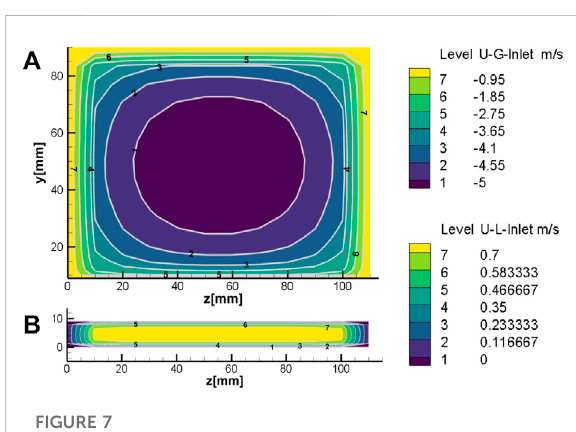
FIGURE 7 Inlet conditions for velocity u, (A) gas inlet, (B) liquid